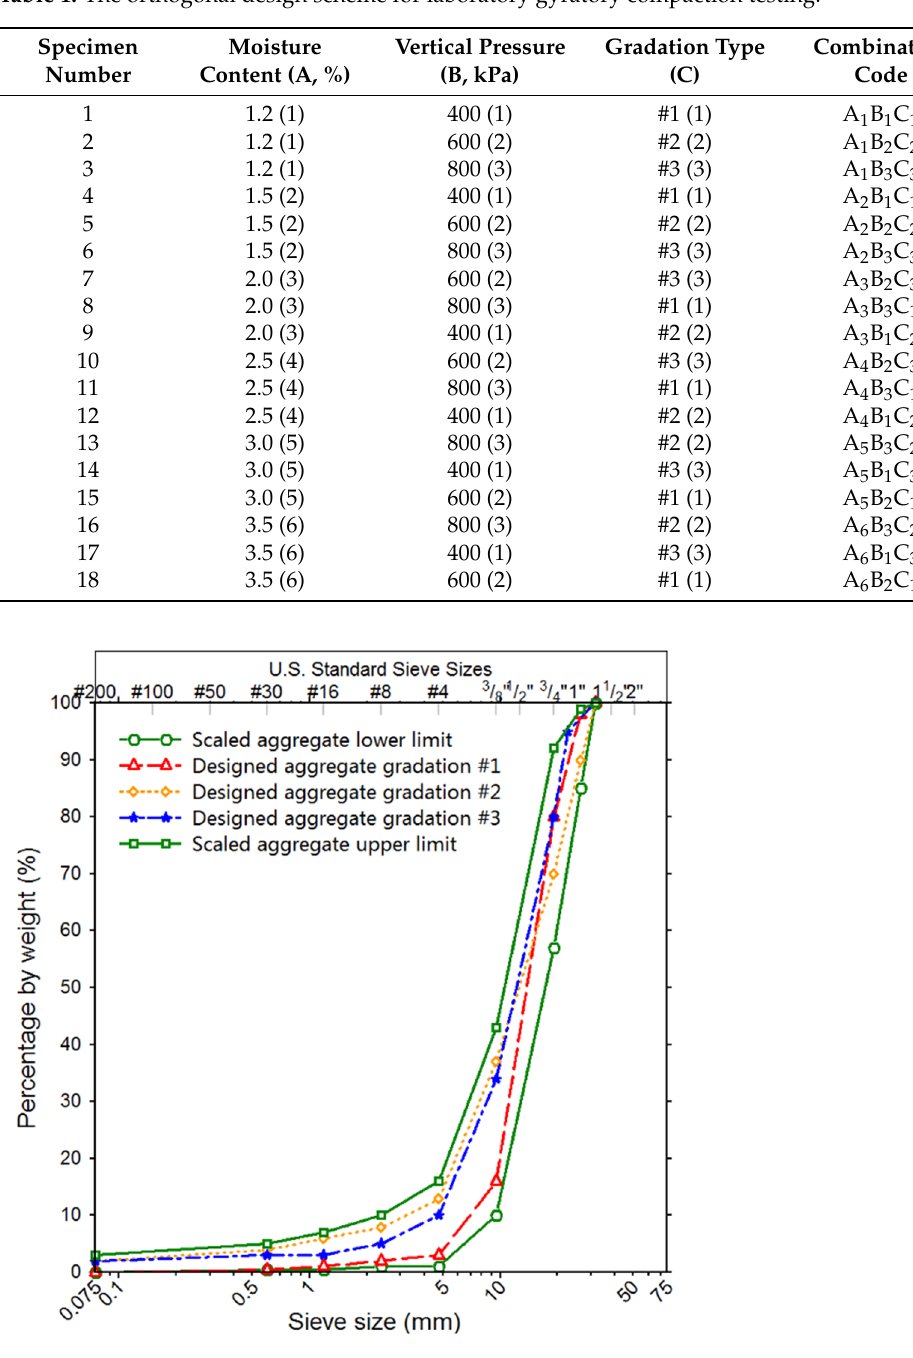
Figure 2. Three different types of scaled aggregate gradation curves studied. Table 1. The orthogonal design scheme for laboratory gyratory compaction testing.